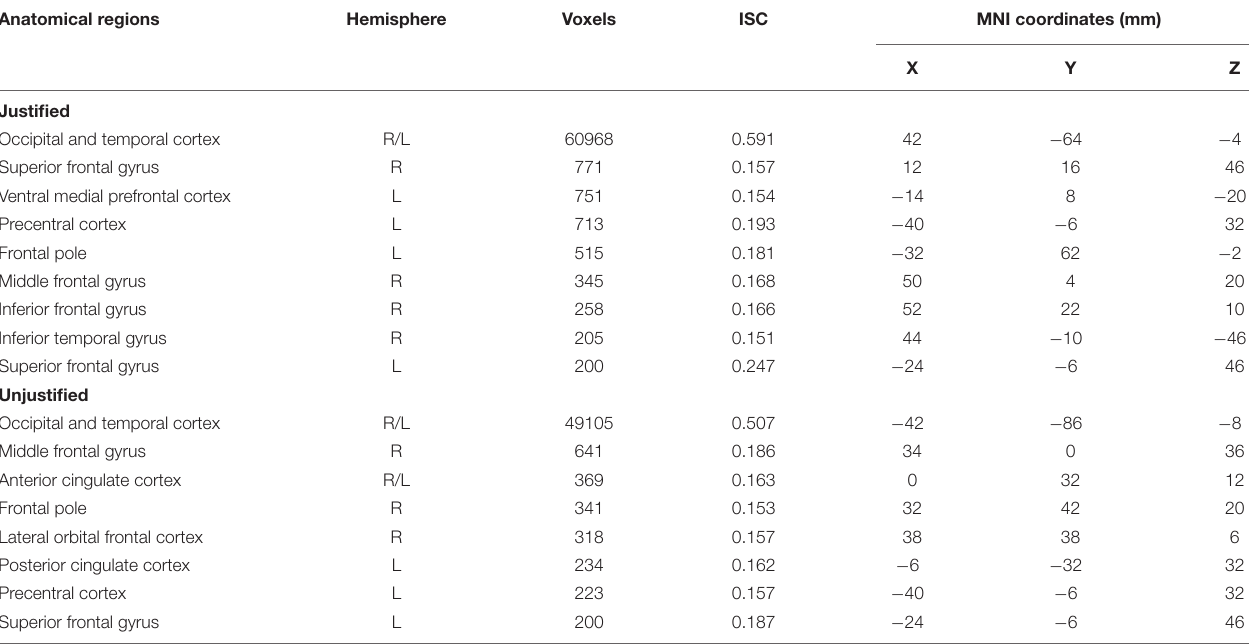
FIGURE 2 | Intersubject correlation for both character and action segments. Significant ISC maps for (A) justified and (B) unjustified movie violence for each 30-min period. Both conditions showed significant ISCs in occipital and temporal cortex associated with visual and auditory processing. The justified condition specifically elicited significant ISC in vmPFC, while the unjustified condition specifically elicited significant ISC in frontal regions including lOFC. The color bar provides the magnitude of ISC values, with a significance threshold set at r < 0.1, after applying a non-parametric family wise error, FWE, correction of q < 0.001. TABLE 1 | Justified versus unjustified